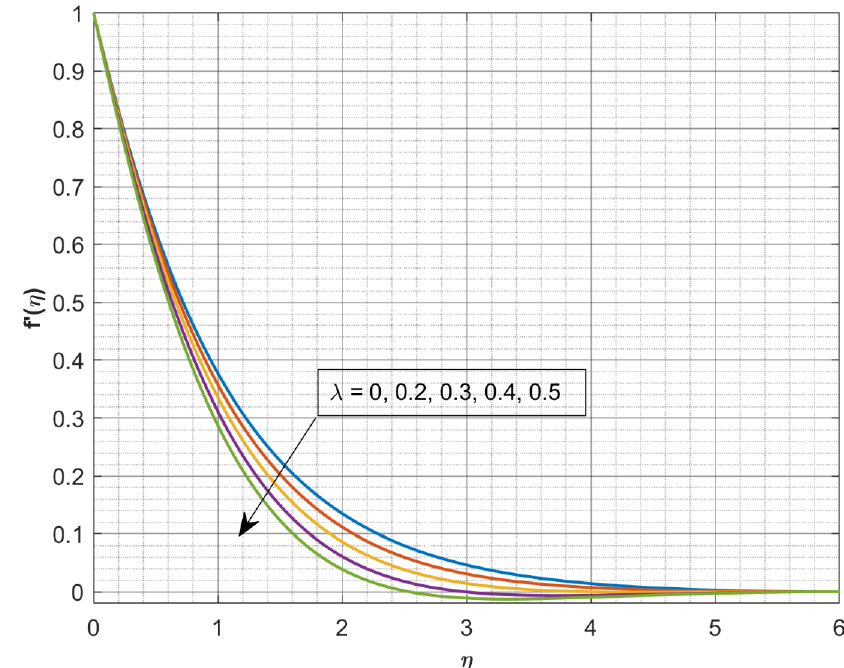
Figure 1. Influence of 𝜆 on 𝑓 ′ (𝜂) .